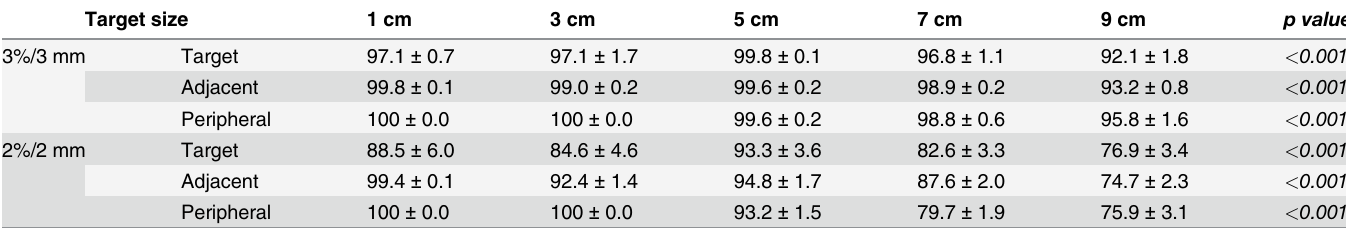
Table 4. Comparison of 3D gamma passing rates of various regions of interest according to target size. Target